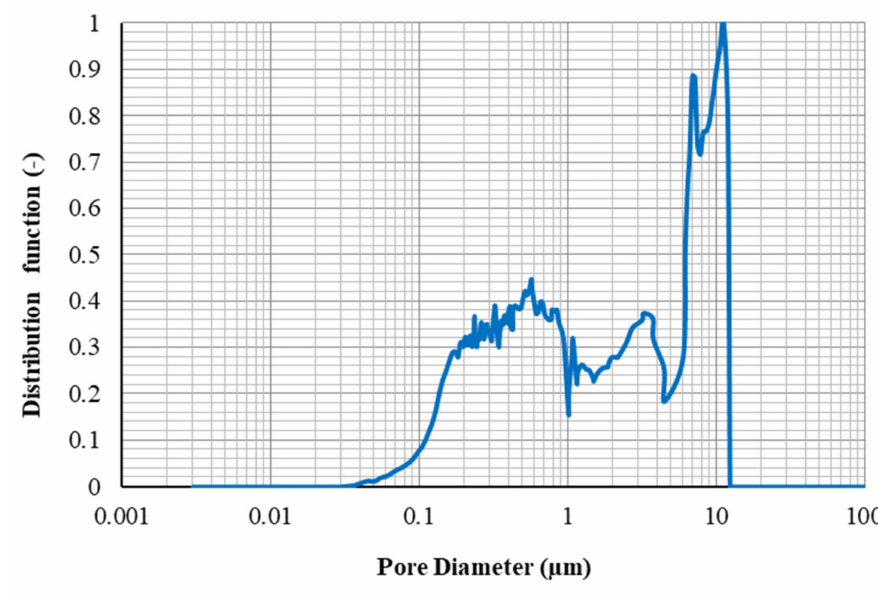
Figure 17. Pore throat size distribution for core